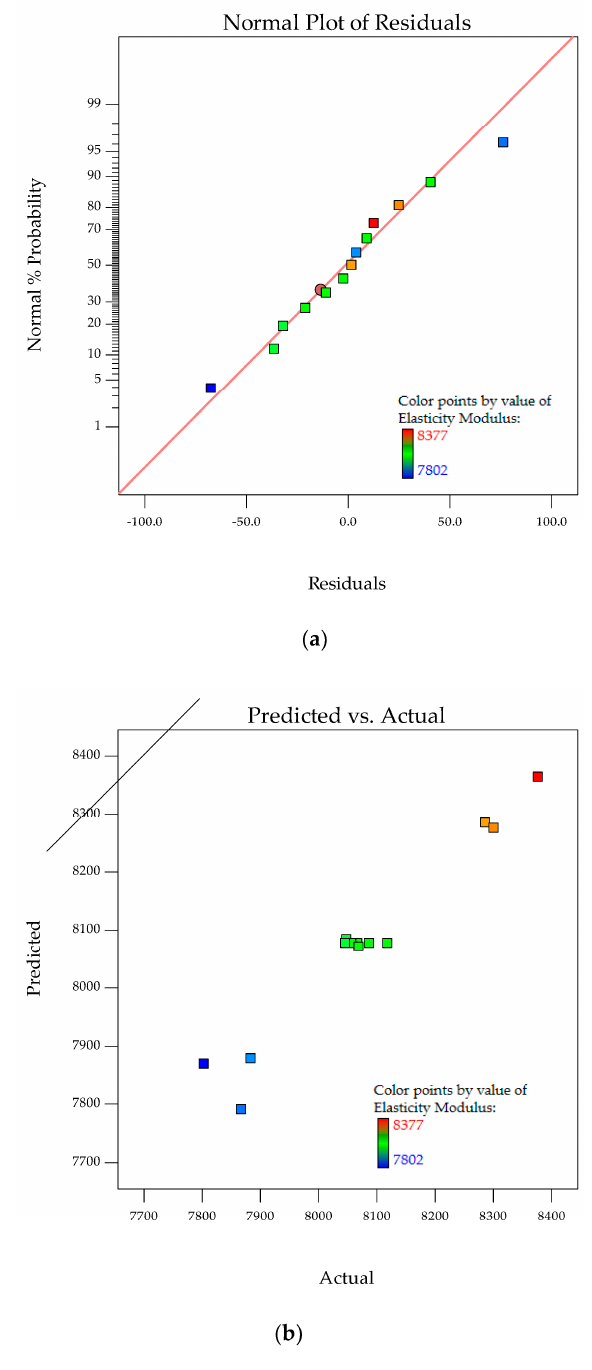
Figure 6. Stochastic error and deterministic portion for elasticity modulus of POM composites as ( a ) normal probability plot for residuals; ( b ) predicted versus actual values.